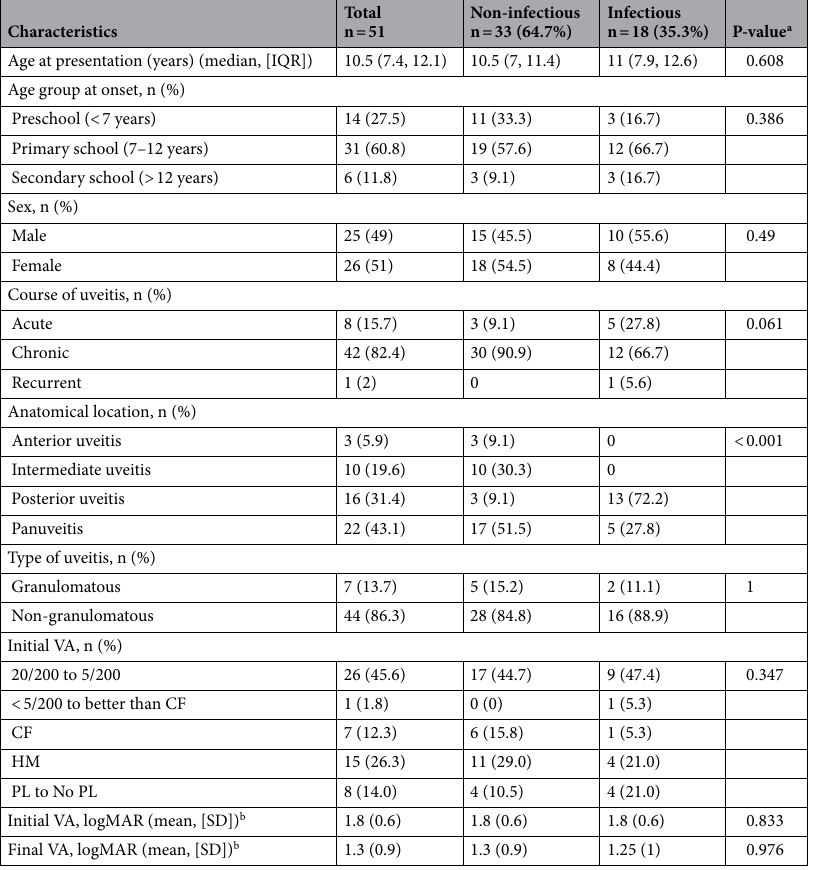
Table 2 summarizes the uveitis diagnosis of all 51 patients. A specific diagnosis of uveitis was established in 24 (47.1%) patients. The remaining 27 (52.9%) children were considered to have undifferentiated uveitis. Uveitis of infectious etiology (35.3%) was roughly three times more common than immune-mediated uveitis (11.8%). Overall, the most frequent specific diagnoses were ocular toxoplasmosis and ocular toxocariasis (9.8% each), followed by diffuse unilateral subacute neuroretinitis (7.8%). Behçet’s disease was the most frequent diagnosis among children with immune-mediated uveitis (3.9%), followed by Vogt–Koyanagi–Harada (VKH) disease (2%), sarcoidosis (2%), systemic lupus erythematosus-related retinal vasculitis (2%), and pars planitis (2%). Treatment. Topical and systemic corticosteroids were prescribed to the majority of the children during treat- ment (84.3% and 80.4%, respectively). IMT was prescribed at some point during the treatment course to 18 of the 33 (54.5%) children with non-infectious uveitis; methotrexate monotherapy was the most frequently pre- scribed IMT (66.7%), whereas six children (33.3%) required combined IMT to achieve uveitis control. A biologic agent (infliximab) was prescribed to only one patient with Behçet’s disease. One or more surgical procedures were performed in 31 eyes (54.4%) of 27 patients. PPV was the most fre- quently performed surgery (31.6%), followed by cataract surgery (24.6%) and glaucoma filtering surgery (10.5%). RD and epiretinal membrane were the most frequent indications for PPV. Frequency of ocular complications at presentation and during follow‑up. At presentation, at least one ocular com- plication was noted in 53 eyes (93%) of 48 children (Table 3). During follow-up, 40 eyes (70.2%) of 36 children developed new ocular complications that did not exist at presentation. The median number of complications per eye at any time during follow-up was 4 (range, 0–9). Among the three children (4 eyes) who did not have ocular complications at presentation, one child with undifferentiated intermediate uveitis developed cataract, IOP elevation, and macular edema during follow-up; the other two had no subsequent ocular complications.